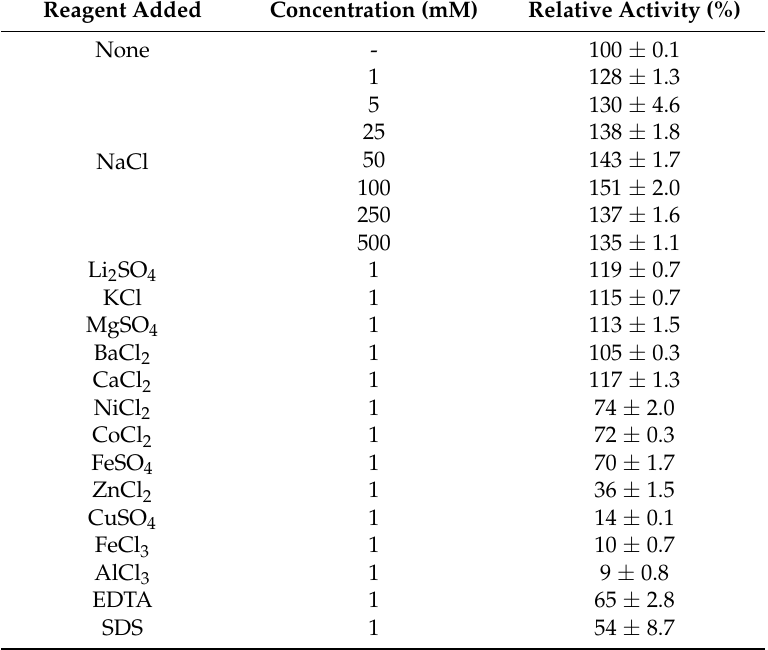
Table 1. Effects of metal ions and chelators on the activity of